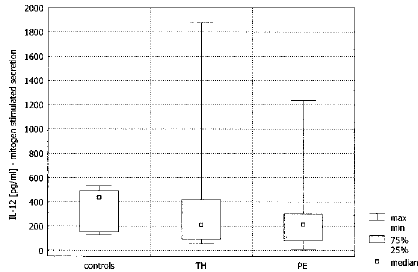
FIG. 2. Comparison of IL-6 PHA-stimulated secretion in healthy pregnant women (controls) ( n = 11), and pregnant women with transient hypertension (TH) ( n = 17) and pre- eclampsia (PE) ( n = 21). Statistically significant are the differences between controls and PE ( p < 0.02) and between TH and PE ( p < 0.002).